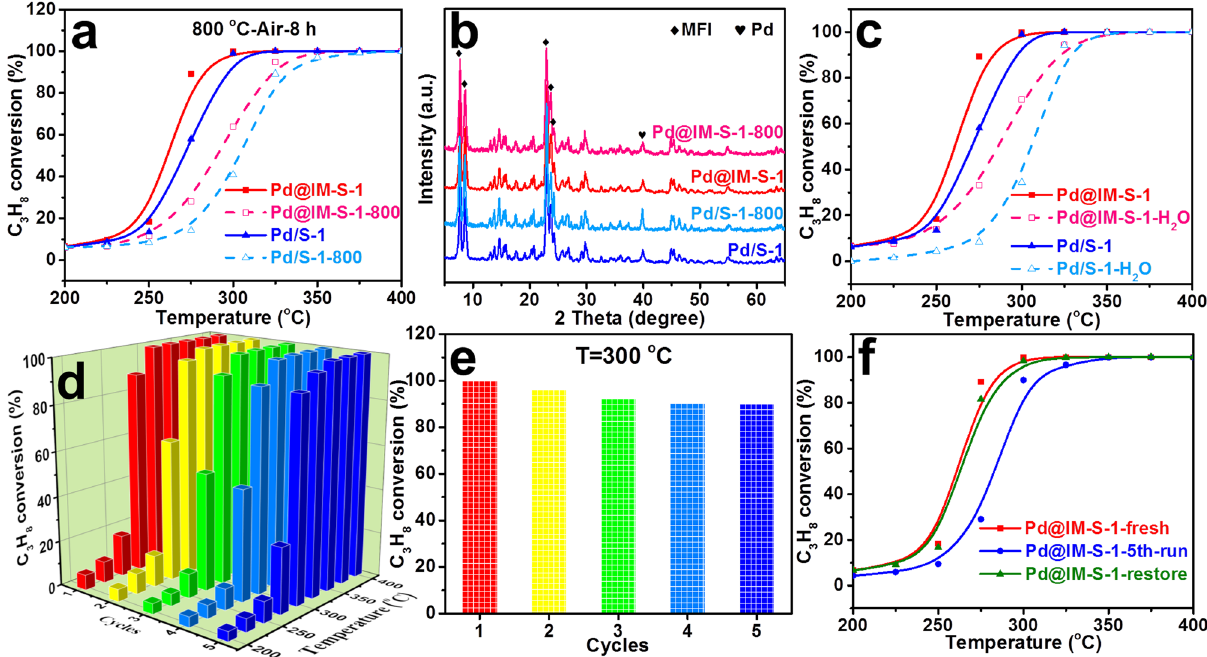
Fig. 7 Stability test of Pd@IM-S-1 and related catalysts. a High temperature thermal resistance, and b XRD patterns of Pd@IM-S-1 and Pd/S-1 before and after thermal treated at 800°C for 8 h in argon; c H 2 O resistance of Pd@IM-S-1 and Pd/S-1 in the oxidation of propane; d , e recycling test of Pd@IM-S-1 in the oxidation of propane and activity at 300 °C; f regeneration test of Pd@IM-S-1 in the oxidation of